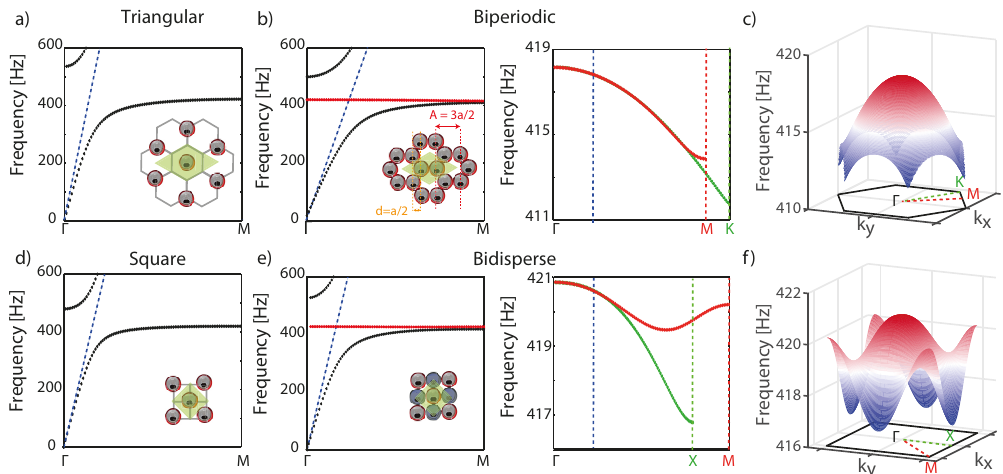
Figure 10. Dispersion relations from numerical simulations with Bloch boundary conditions. ( a ) a triangular lattice of soda cans displays the polaritonic dispersion behaviour while ( b ) the honeycomb lattice which consists of the superposition of two triangular ones exhibit the presence of a negative band in the two principal directions of the crystal. ( c ) The surface plot of this band shows the almost isotropic nature of this band. Similarly, ( d ) the square lattice of soda cans displays the polaritonic dispersion while ( e ) a square lattice made of two resonators with two different resonant frequencies shows a negative band. ( f ) The surface plot for this bidisperse crystal shows less isotropy but near its upper edge it seems